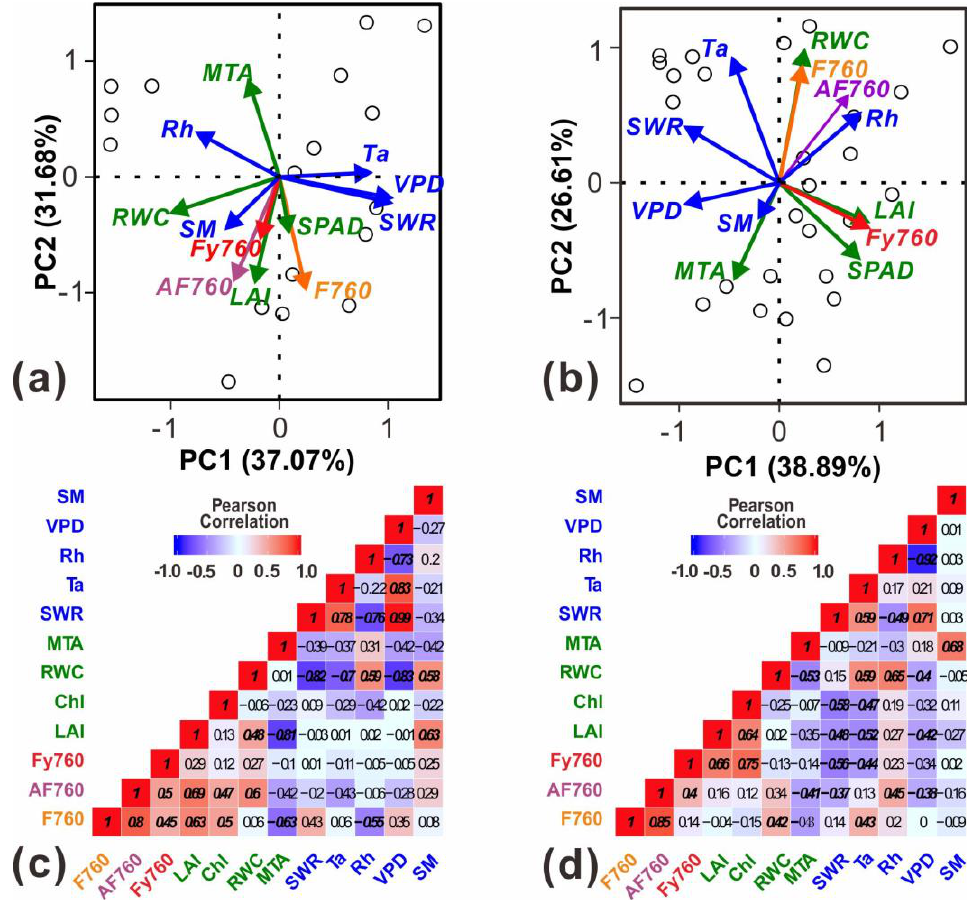
Figure 6. Relationships of environmental/growth parameters with F760, AF760, and Fy760 at the seasonal scale. Left column is wheat and right column is maize. ( a , b ) are PCA results and ( c , d ) are Pearson correlation results. The relationships between variables in PCA is indicated by vector angle: if the vector angle between two variables is acute, they were positively correlated; else if the angel is obtuse, these two variables were negatively correlated (right angle represents uncorrelated). The smaller the included angle was, the higher the correlation it showed. The significant correlation between each of the two variables ( p -value < 0.05) in ( c ) and ( d ) is shown in italics/bold. Only the measurements synchronously collected with growth parameters were used for PCA and Pearson correlation analysis.